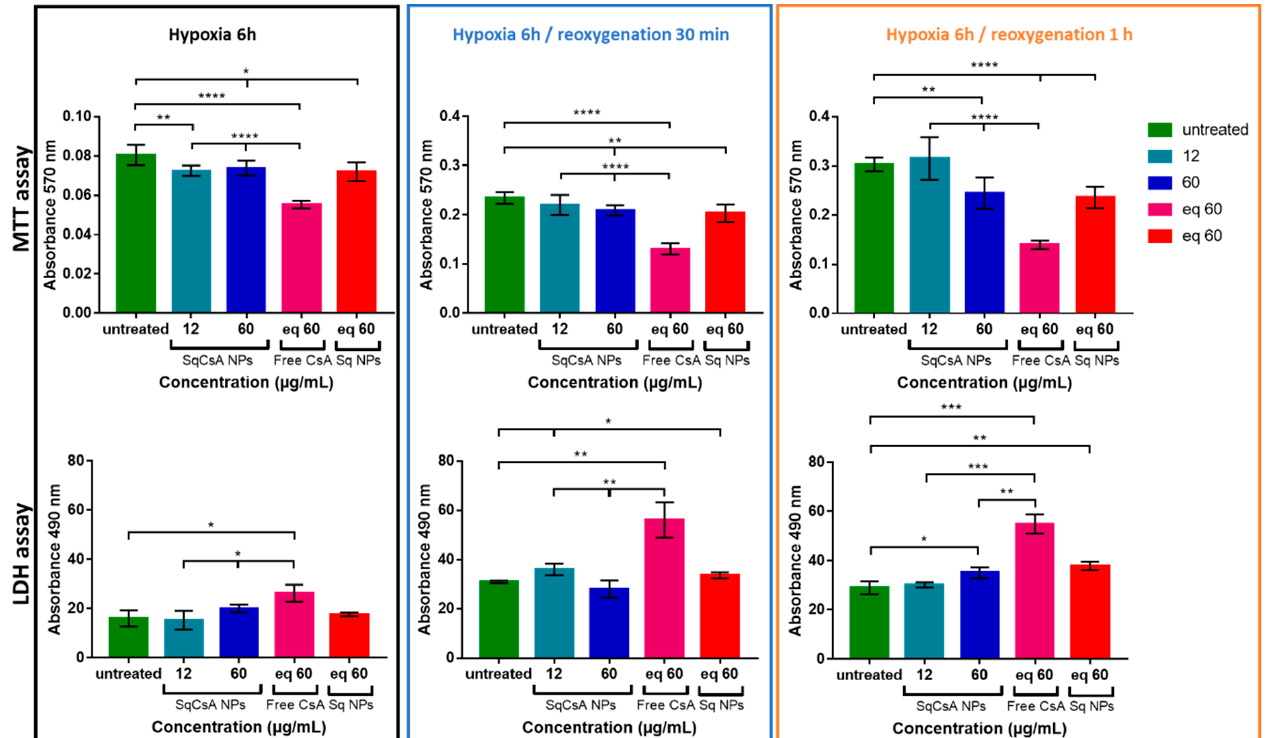
Figure 9. Cardioprotective effect assessment on MCEC cell line. Cells were incubated with SqCsA NPs for 24 h. Controls (untreated cells, free CsA, or Sq NPs) were done under the same conditions. After incubation time, cells were rinsed with PBS and incubated in hypoxic condition (1% O 2 and restraint medium without FBS and glucose). Cardioprotection was assessed by using MTT test (upper panel) and LDH test (lower panel). For the MTT tests, the higher the percentage, the more viable the cells. For the LDH tests, the higher the percentage of LDH-released protein, the more damaged the cells. * p ≤ 0.05, ** p ≤ 0.01, *** p ≤ 0.001, **** p ≤ 0.0001.